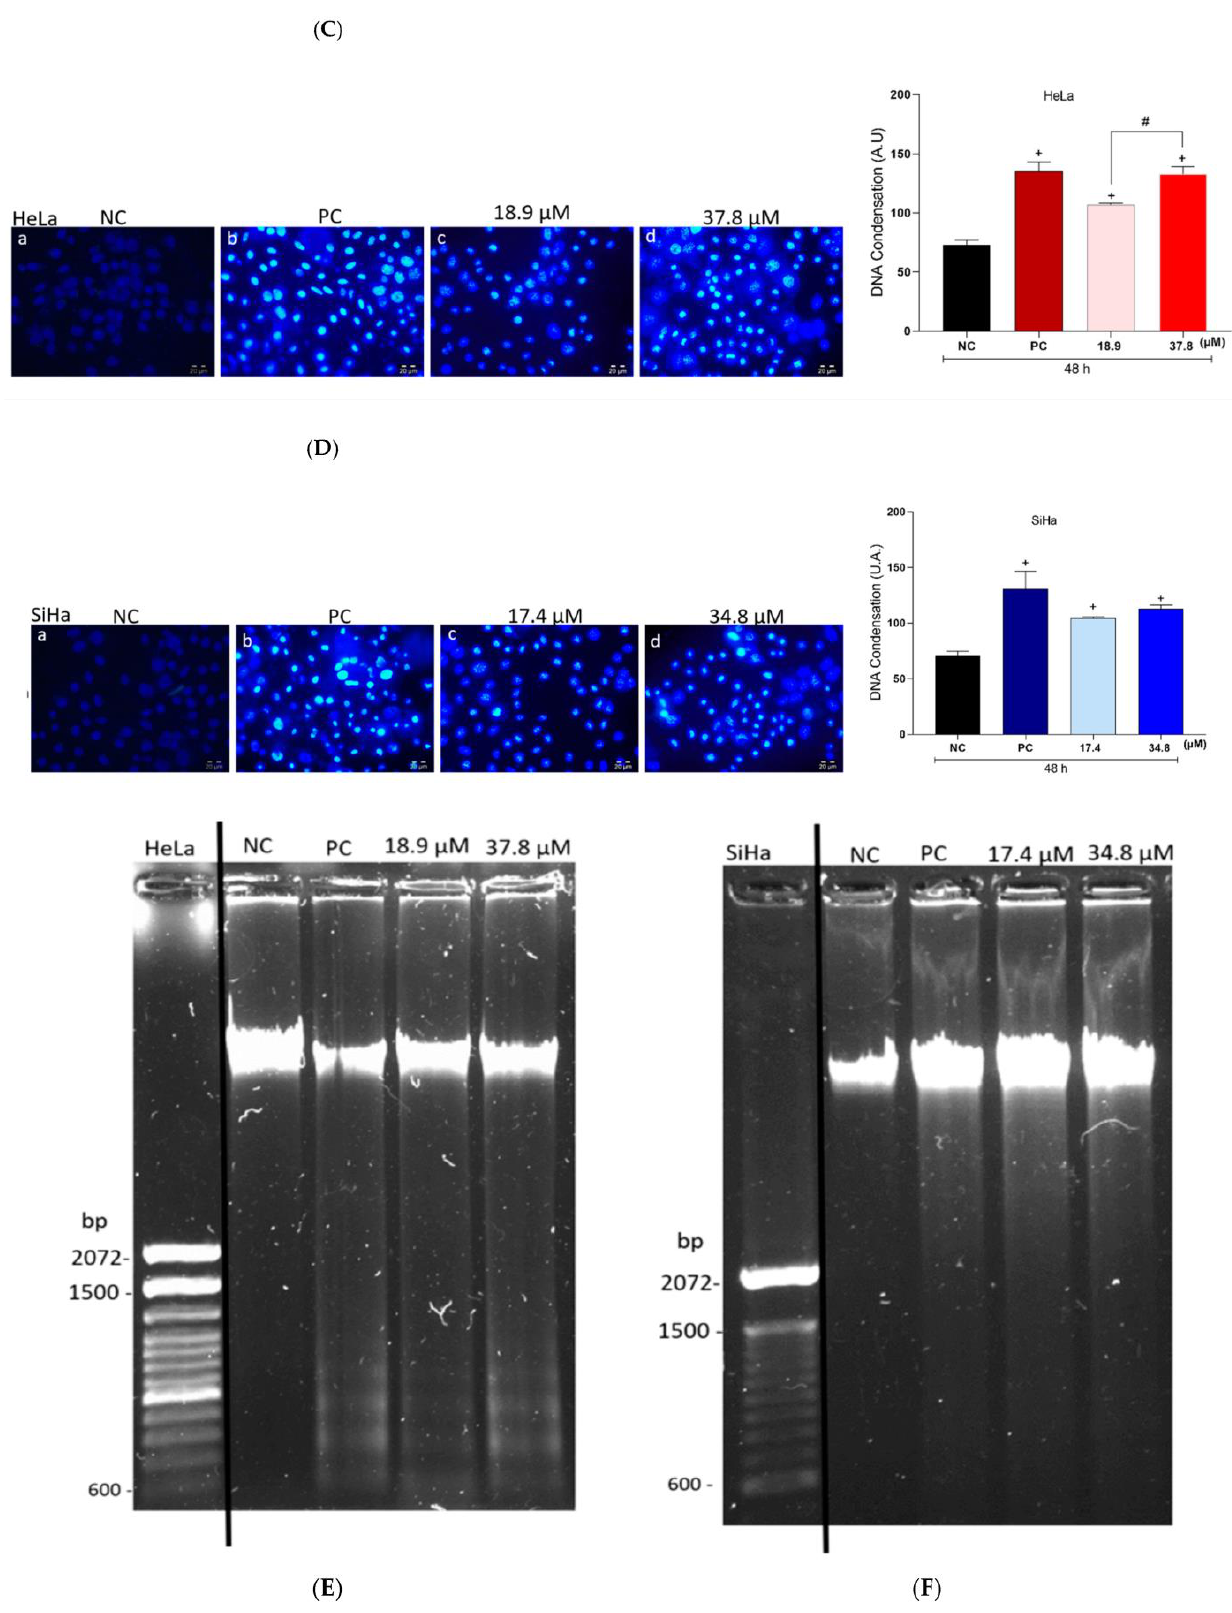
Figure 8. Effects of A3K2A3 on the DNA of cells. Cell cycle analysis in ( A ) HeLa and ( B ) SiHa. Evaluation of chromatin condensation by Hoechst stain 33342 in ( C ) HeLa and ( D ) SiHa.